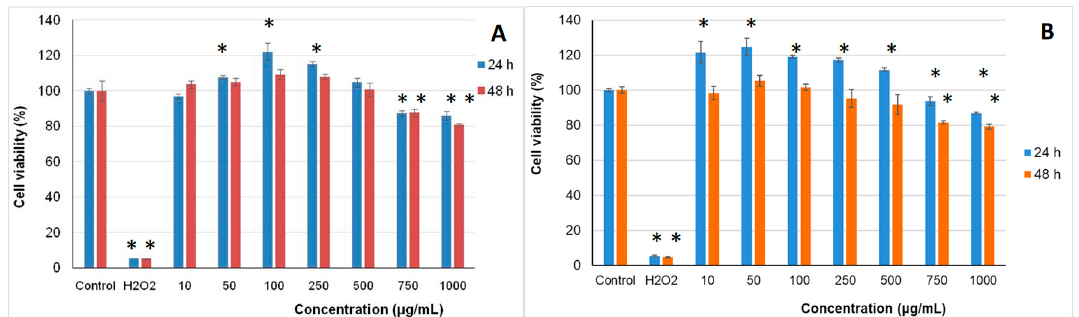
Figure 3. Cell viability of L929 fibroblasts cultivated in the presence of microencapsulated black rice extracts in variant 1 ( A ) and variant 2 ( B ) for 24 h and 48 h, respectively, determined by NR assay. The results are expressed as percent relative to the control culture (untreated), considered 100% viable. The values represent mean ± SD ( n = 3). * p < 0.05, compared to control.